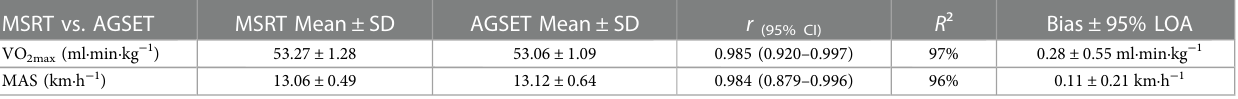
TABLE 4 Results of the correlation and Bland and Altman analysis between maximal oxygen uptake and maximal aerobic speed derived from the multistage shuttle run test and the artistic gymnastic-speci fi c endurance test. MSRT vs. AGSET